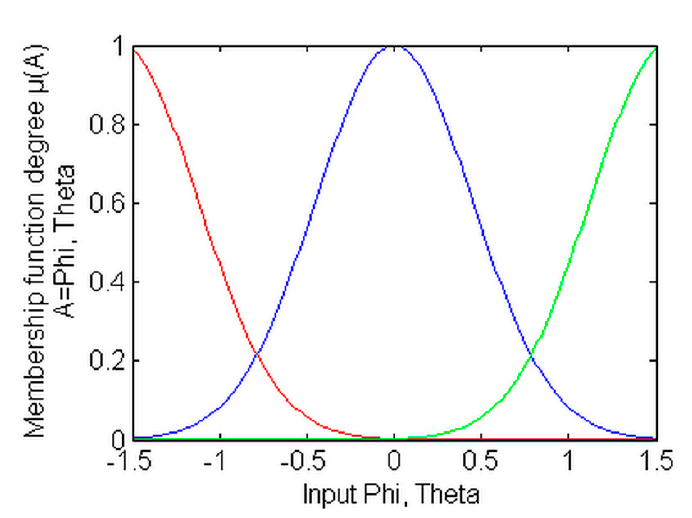
Figure 14. Membership functions of the IT2-AFS 1 ˆ g .